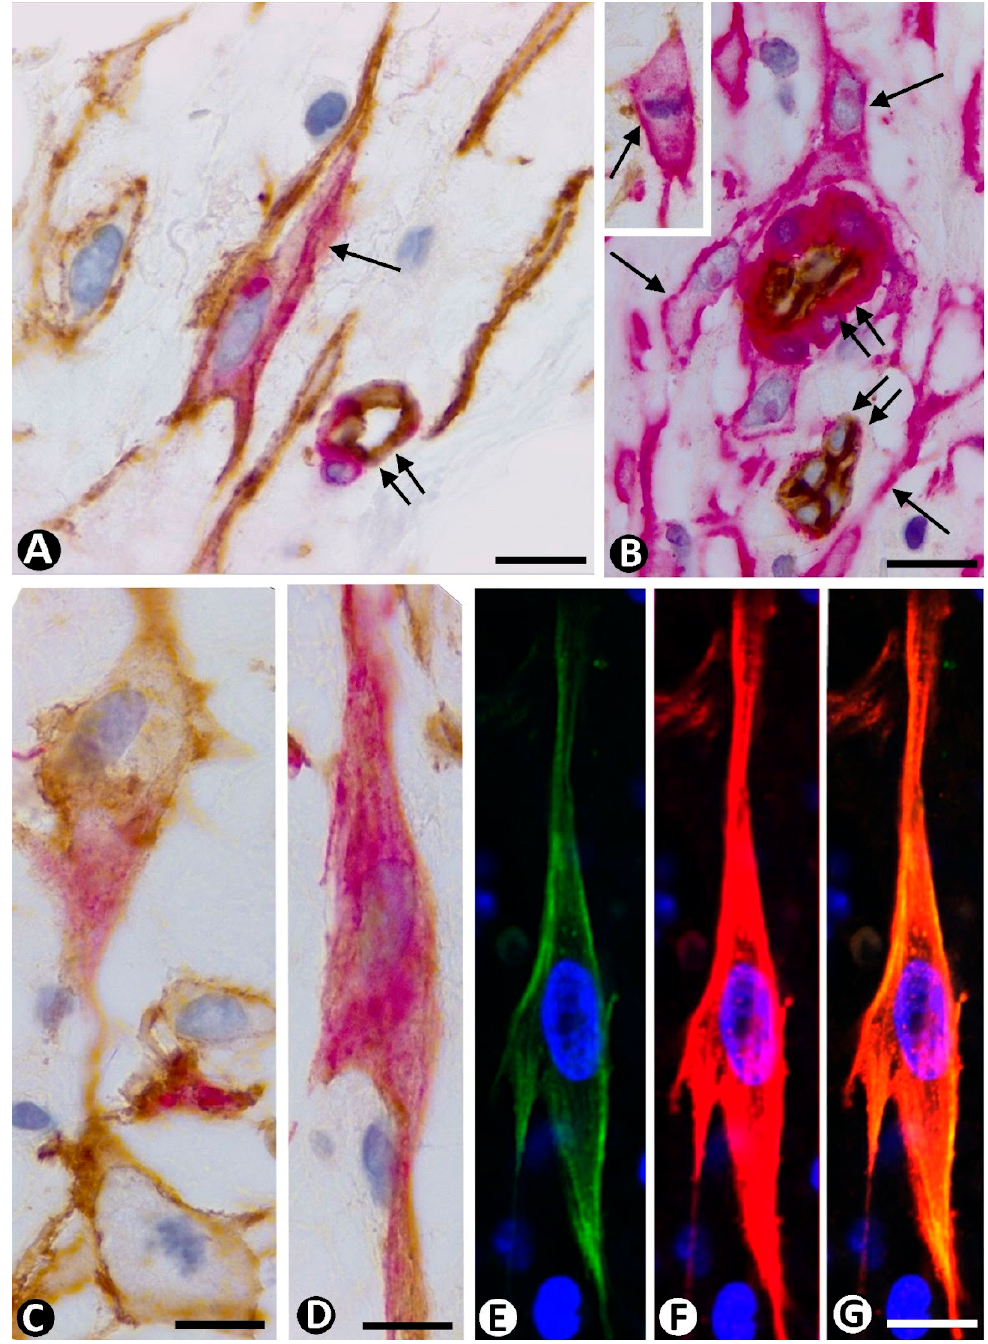
Figure 7. ( A ): Presence of CD34+SCs/TCs (brown) and a stromal cell (arrow) suggesting expression of CD34 (brown) and α SMA (red) around a small vessel (double arrow) with an endothelial cell (brown) and a pericyte (red). ( B ): All stromal cells (arrows) around vessels (double arrow) are myofibroblasts expressing α SMA (red). Insert of ( B ): A myofibroblast in mitosis (arrow). ( C , D ): Details of stromal cells suggesting transitional cell forms between CD34+SCs/TCs and myofibroblasts by double immunochemistry for CD34 and α SMA. ( E – G ): Co-expression of CD34 and α SMA observed in a stromal cell by double immunofluorescence labeling for CD34 and α SMA. ( A – D ): Double immunochemistry for CD34 (brown) and α SMA (red). ( E – G ): Double immunofluorescence in confocal microscopy for CD34 ( E , green), α SMA ( F , red), and merged ( G ). Bar: ( A ): 8 µ m; ( B ): 30 µ m; ( C – G ): 8 µ